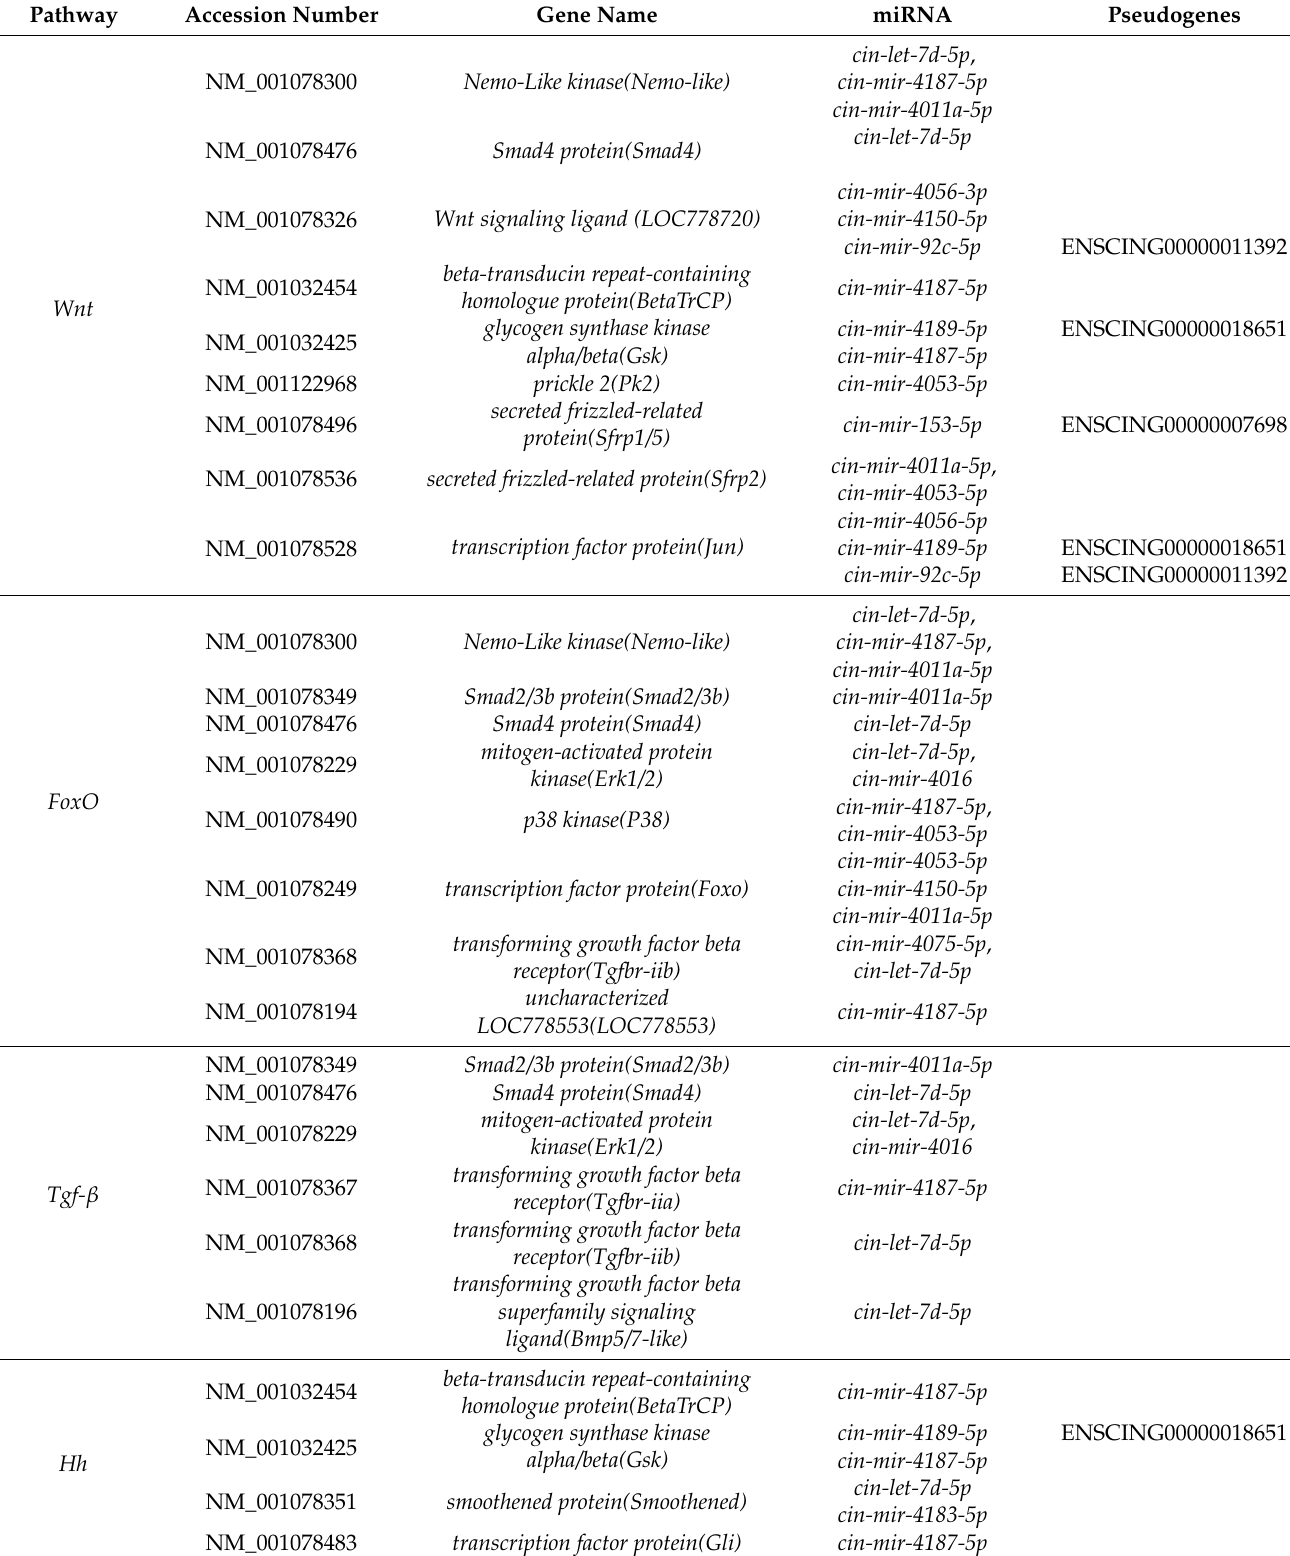
Table 5. mRNA-miRNA-pseudogene interaction network of Tgf- β , Wnt , FoxO , and Hh pathways. miRNA and pseudogenes interacting couples are showed in the same